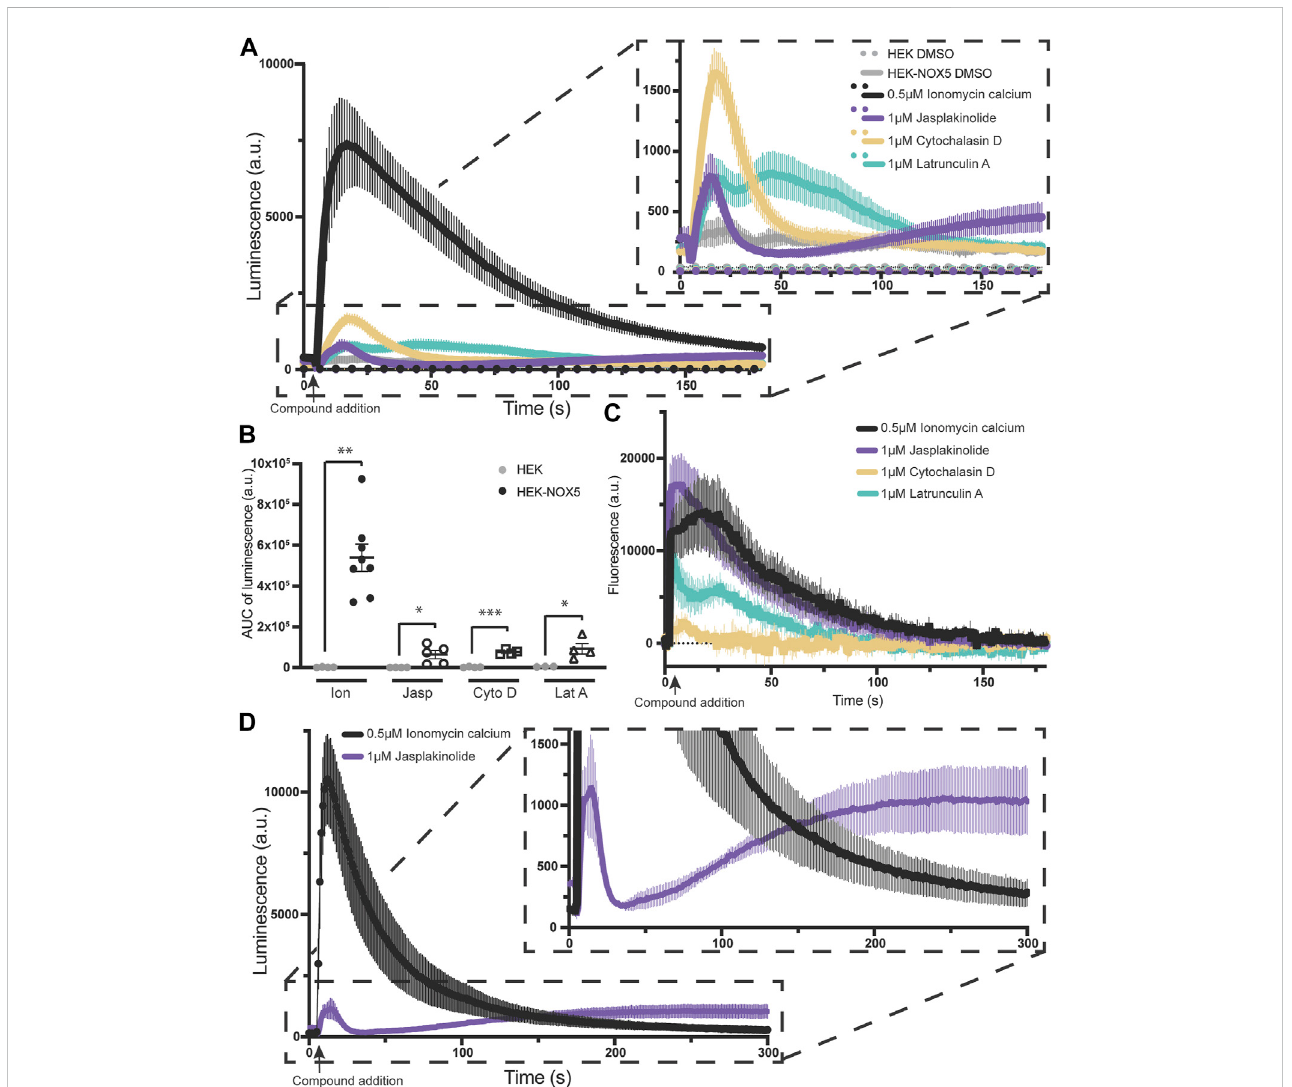
FIGURE 3 Actin effectors alone are suf fi cient for NOX5 stimulation. (A) Timecourse of superoxide production by HEK293 cells and HEK293 cells stably expressing NOX5afterautomatedadditionofDMSO,ionomycincalcium(0.5 μ M),jasplakinolide(1 μ M),cytochalasinD(1 μ M)orlatrunculinA(1 μ M)andmeasuredusing L-012 luminescence. (B) Quanti fi cation of NOX5 superoxide production (area under the curve). Values represent means ± SEM, n = 3 – 8. Differences in superoxide production upon compound addition by HEK293 cells stably expressing NOX5 compared to HEK293 control cells were assessed using Student ’ s t -test with * denoting p < 0.05, ** p < 0.001 and *** p < 0.0001. (C) Changes in intracellular calcium levels after automated addition of DMSO, ionomycin calcium (0.5 μ M), jasplakinolide (1 μ M), cytochalasin D (1 μ M) or latrunculin A (1 μ M) measured using the FLIPR Calcium 6 Assay Kit